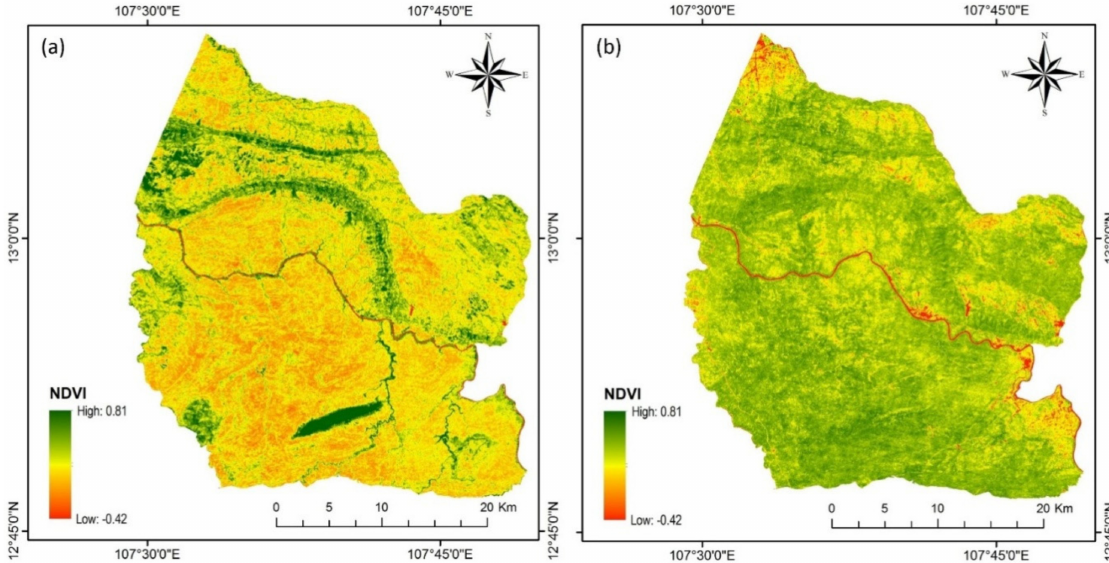
Figure 4. Normalized difference vegetation index (NDVI) images generated from Landsat 8 cloud-free composite images: ( a ) NDVI image in the dry season and ( b ) NDVI image in the rainy